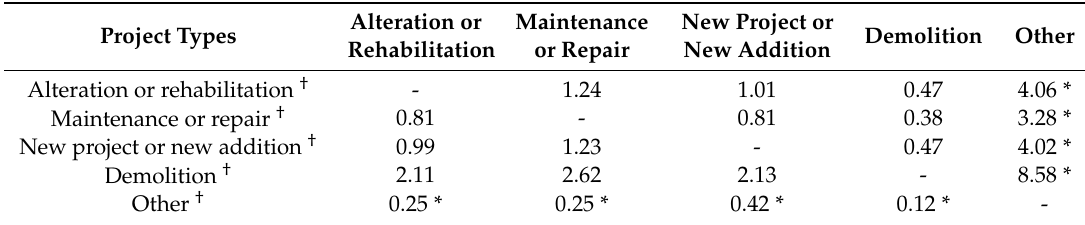
Table 8. Odds ratios of fatal accidents among di ff erent project